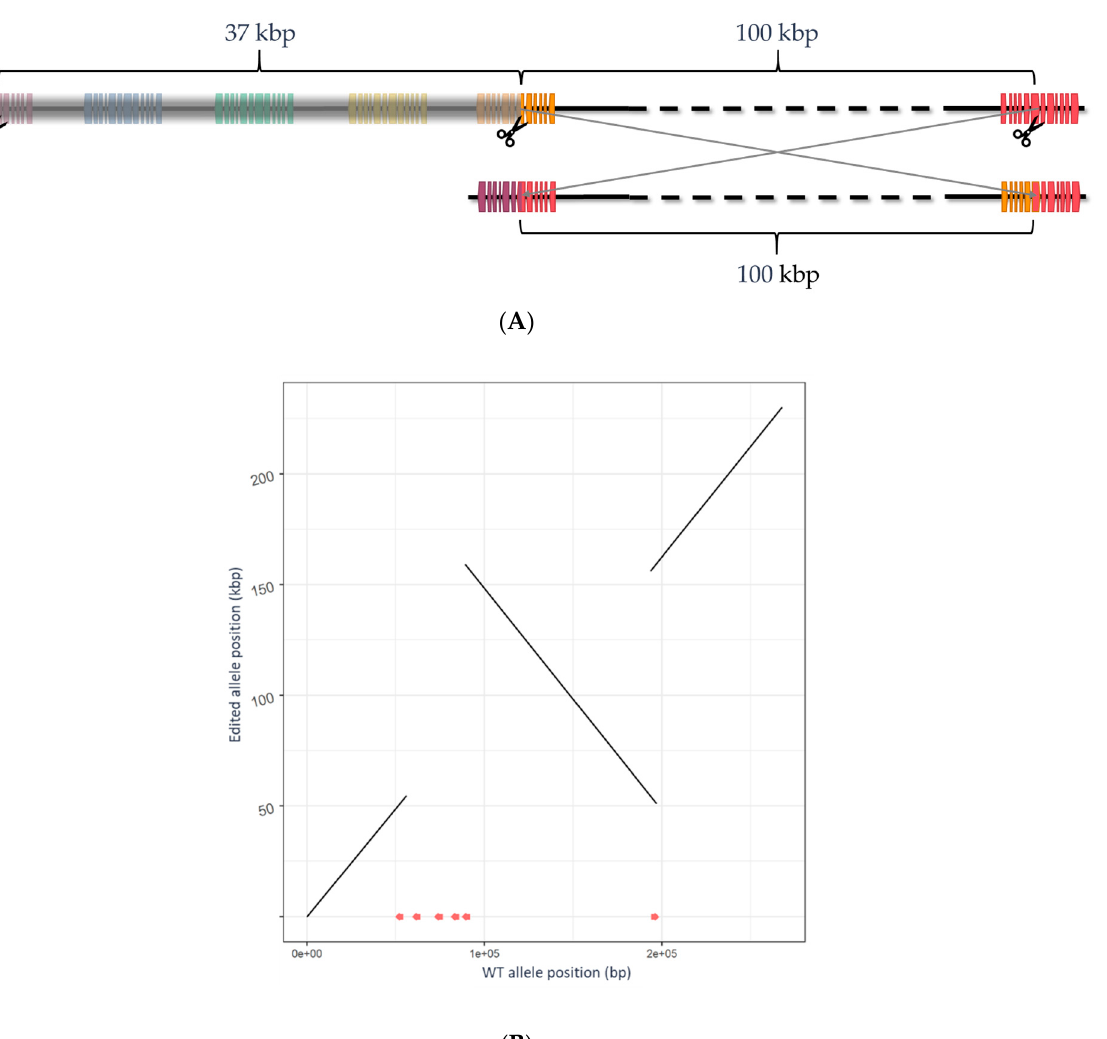
Figure 4. The structural variation produced in the cluster of six myrosinase genes on chromosome B04. ( A ) Schematic diagram of the structural variation produced (intergenic regions not to scale). The top segment shows the original genomic structure and three evident Cas12a cut sites (scissors). The bottom segment shows the structural variation comprising a 37 kbp deletion spanning three entire genes and a 100 kbp inversion resulting in two chimeric genes both with premature stops in exon 6. B04_cl1.1_rg (green); B04_cl1.2_rg (yellow); B04_cl1.3_rg (orange); B04_cl1.4_rg (red); B04_cl1.5_rg (purple); B04_cl1.6_rg—not expressed (blue); 37 kbp region deleted low-lighted in gray. ( B ) Dot plot showing ~270 kb region of chromosome B04 with structural variant in edit allele ( y -axis), including ~100 kb inversion and ~37 kb deletion. Myrosinase gene models are shown with red line segments along the x -axis.